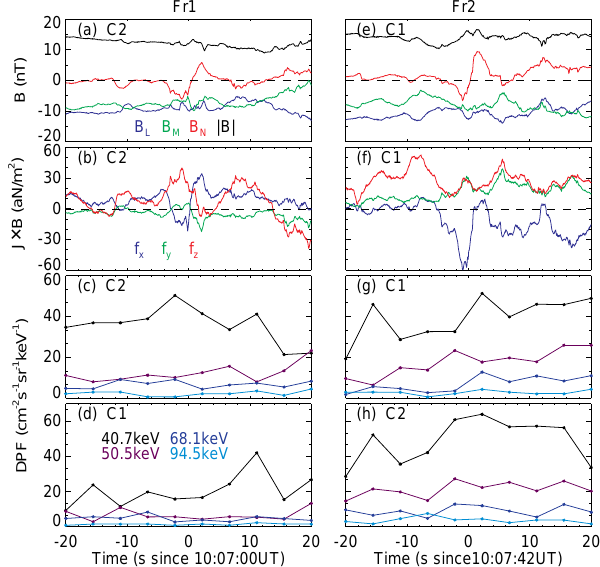
Fig. 5. (a) the magnetic field in the local minimum variance coordi- nates (LMN), (b) the three components of the Lorentz force J × B in GSM coordinates, and the high energy electron fluxes at (c) C2 and (d) C1 around Fr1 are presented. (e–h) show the similar data around Fr2 in the same